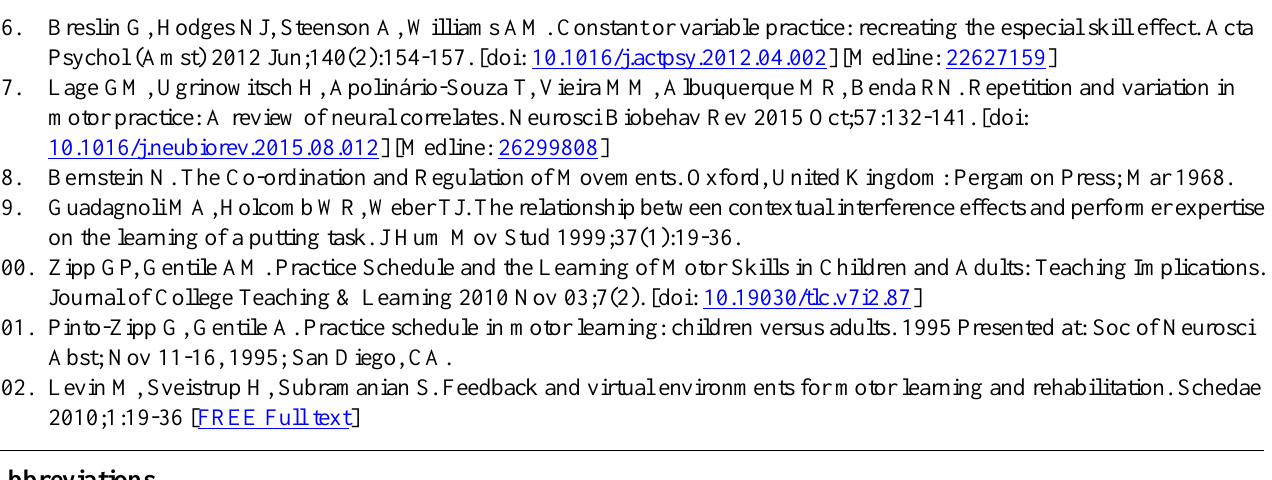
CP: cerebral palsy MeSH: Medical Subject